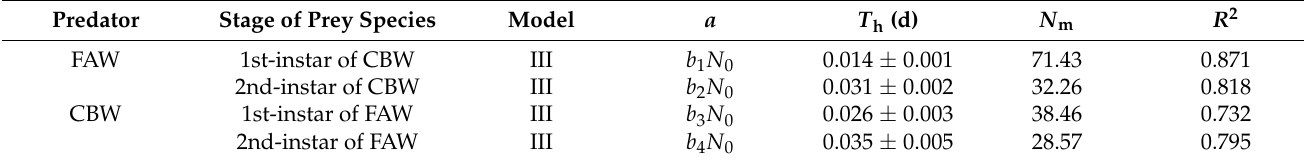
Figure 2. Functional response curves of sixth-instar predator larvae of Spodoptera frugiperda (FAW) or Helicoverpa armigera (CBW) preying on first- ( a ), second ( b ) larvae of each other. Table 3. The attack rate (a), handling time (T h) , and theoretical maximum prey consumption (Nm) of sixth-instar larvae of Spodoptera frugiperda (FAW) preying on Helicoverpa armigera (CBW) and CBW preying on FAW at different prey